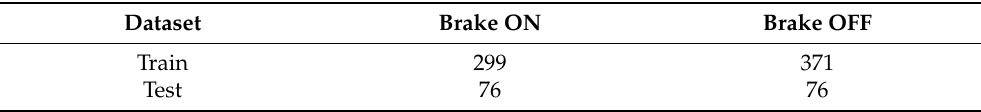
Table 2. Images in the dataset.